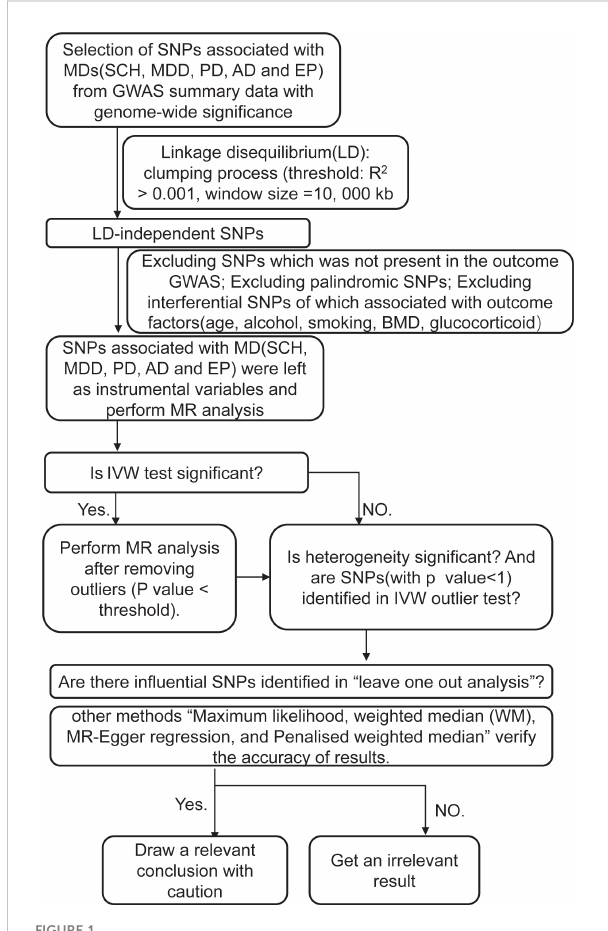
FIGURE 1 A step-by-step illustration of the study design and work fl ow. SNP, single-nucleotide polymorphism; MDs, mental diseases; SCH, schizophrenia; MDD, depression; AD, Alzheimer ’ s disease; PD, Parkinson ’ s disease; EP, epilepsy; GWAS, genome-wide association studies; BMD, bone mineral density; MR analysis, Mendelian randomization analysis; IVX, inverse variance